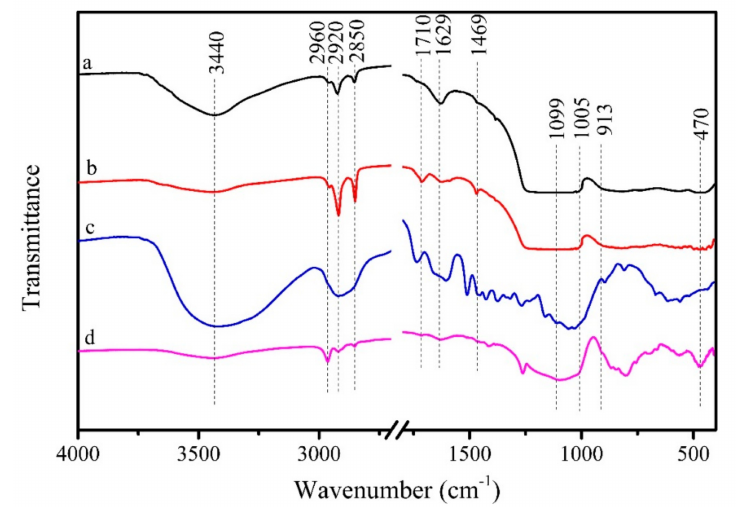
Figure 3. FTIR spectra of ( a ) KL; ( b ) STA modified KL; ( c ) LC; ( d ) LC coated with